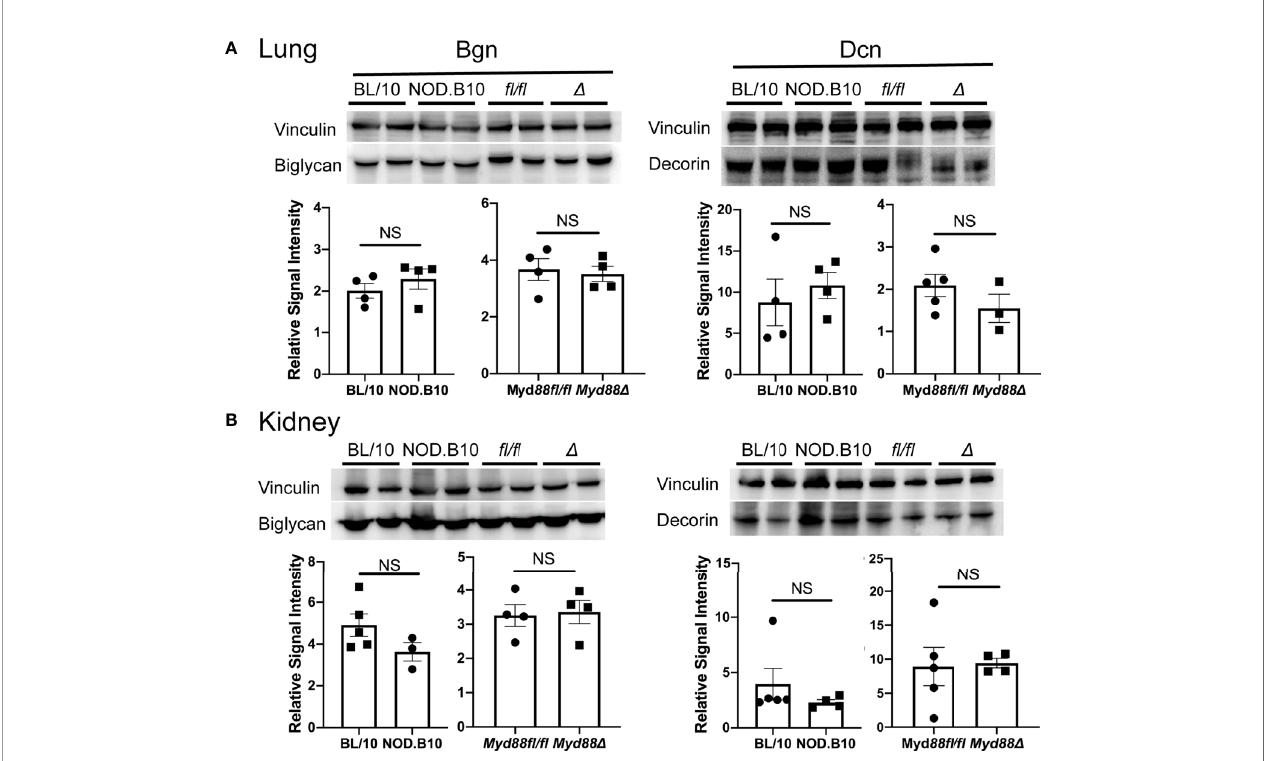
FIGURE 4 | Bgn and Dcn are expressed in lung and kidney. Western blotting was performed on (A) lung and (B) kidney tissue derived from BL/10 (n = 9 or 10), NOD.B10 (n = 6 or 7), NOD.B10 Myd88 fl / fl (n = 8), and NOD.B10 Myd88 D mice (n = 7 or 8). Representative levels of Bgn and Dcn from 2 animals of each strain are shown and protein expression was normalized to vinculin. Data from one of two independent experiments are shown. Horizontal lines represent the mean and SEM, (NS, non-signi fi cant). fl / fl = NOD.B10 Myd88 fl / fl and D = NOD.B10 Myd88 D